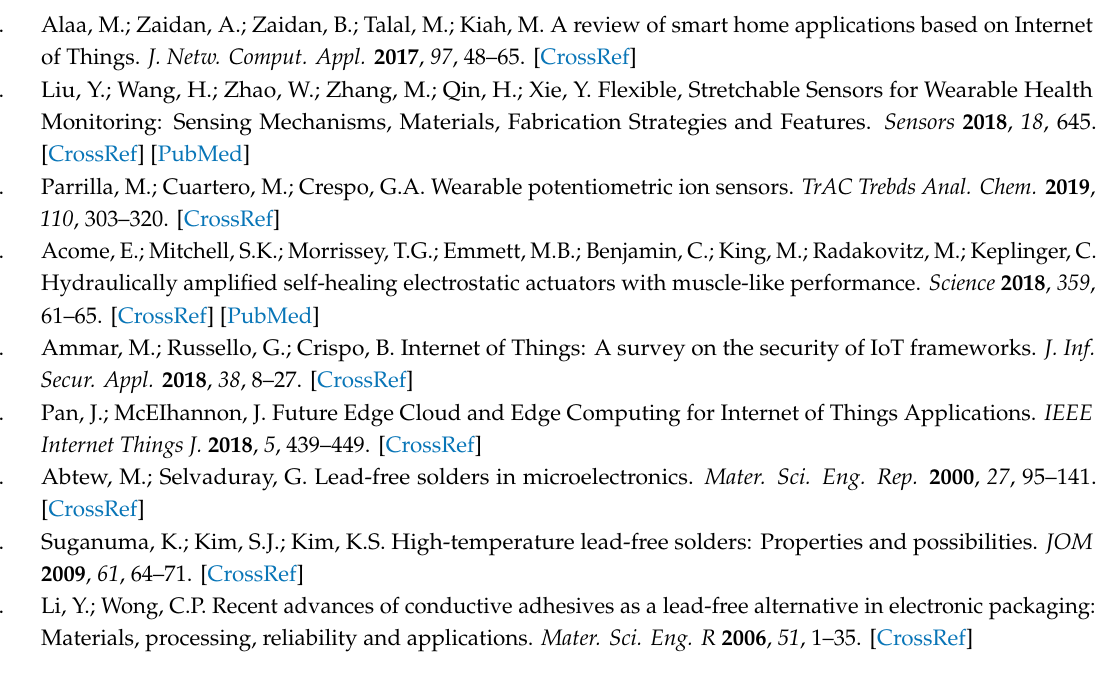
Figure S1: ( a ) A photograph and ( b ) an optical image of solder paste before MW heating process on polyimide sheet. ( c ) A photograph and ( d ) an optical image of solder paste after MW heating process on polyimide sheet, Figure S2: ( a )TG / DTA and ( b ) DSC curves of solder paste at a scan rate of 5 ◦ C / min in air, Table S1: (cid:52) T (1, 0.5) , (cid:52) T (cid:52) T (cid:52) T (cid:52) T (cid:52) T (cid:52) T (cid:52) T (cid:52) T (cid:52) T (cid:52) T (1, 1) , (1, 5) , (1, 10) , (1, 15) , (1, 20) , (0.5, 1) , (5, 1) , (10, 1) , (15, 1) , and (20, 1) by MW irradiating at 1, 5, 10, 20, 30 W output powers for 30 s. The thickness of the samples is 12 mm. The thickness of the samples is 12 mm, Table S2: Information about number of elements, meshfree time, and solution time of magnetic field distribution in simulation using Comsol Multiphysics ®